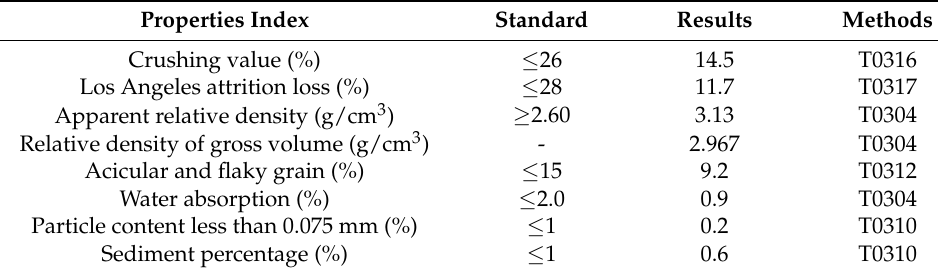
Table 3. Technical indicators of coarse